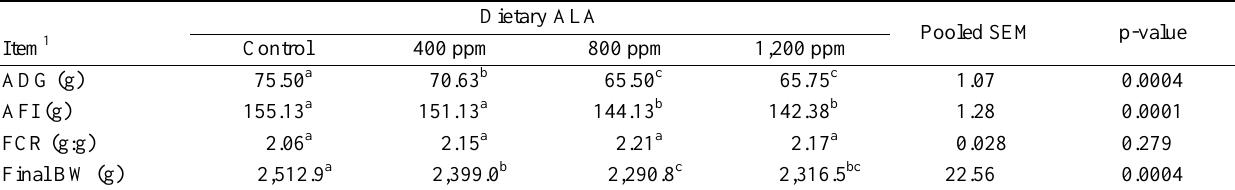
Table 2. Effects of dietary ALA on growth performance of